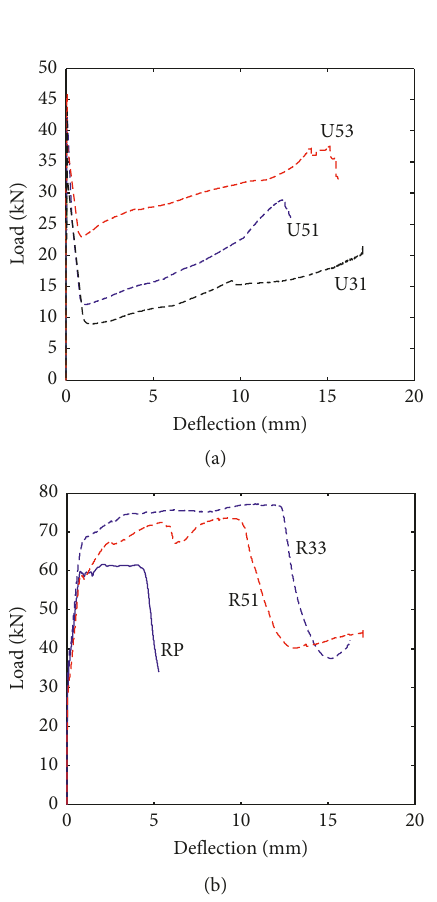
Figure 8: Load-deflection curves of (a) U-series and (b)